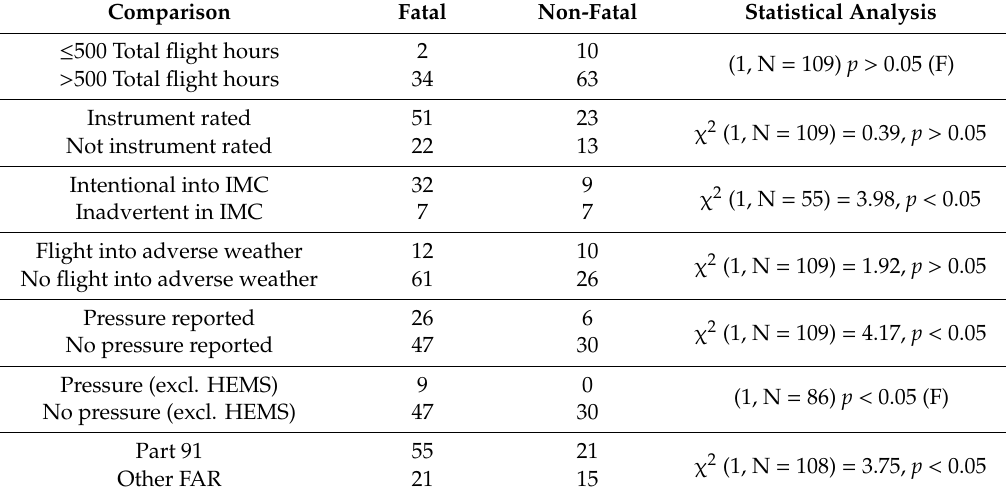
Figure 1. Number of Accidents between 1992 and 2016. Table 1. Distribution of fatal and non-fatal accidents for helicopters encountering fog.